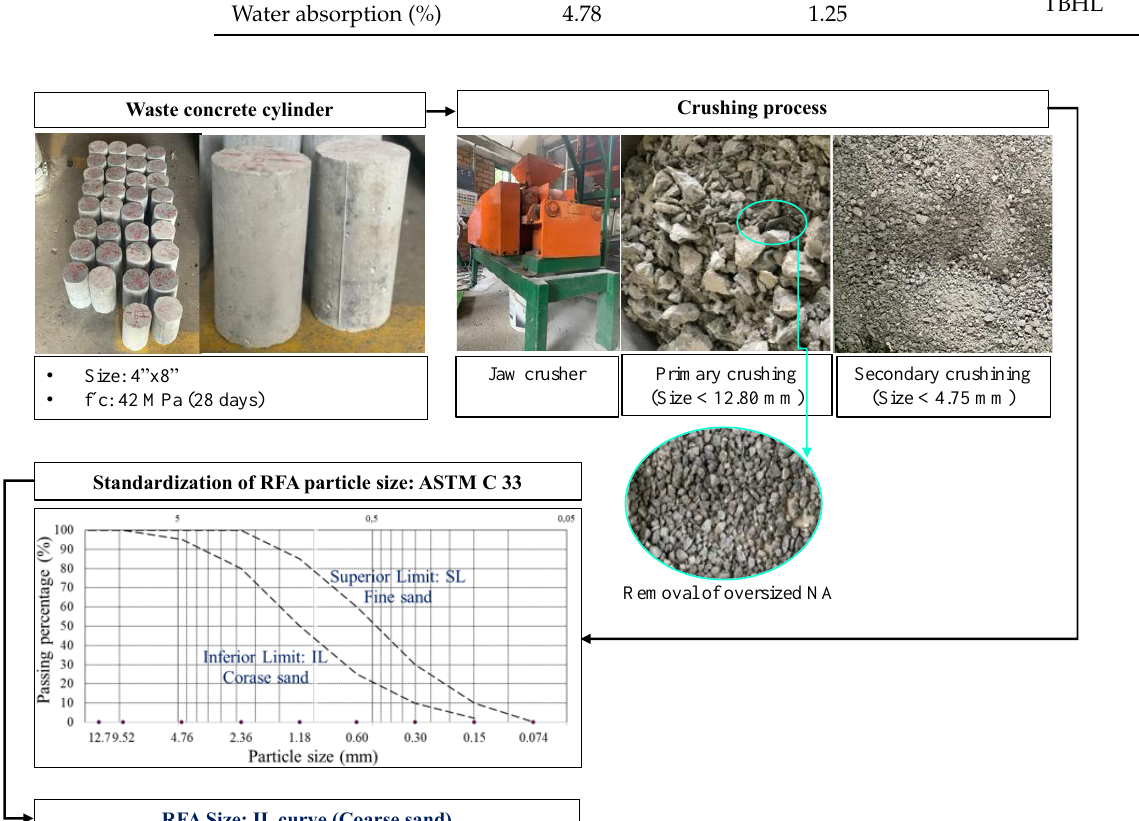
Figure 1. Schematic illustration of transformation process of concrete waste.